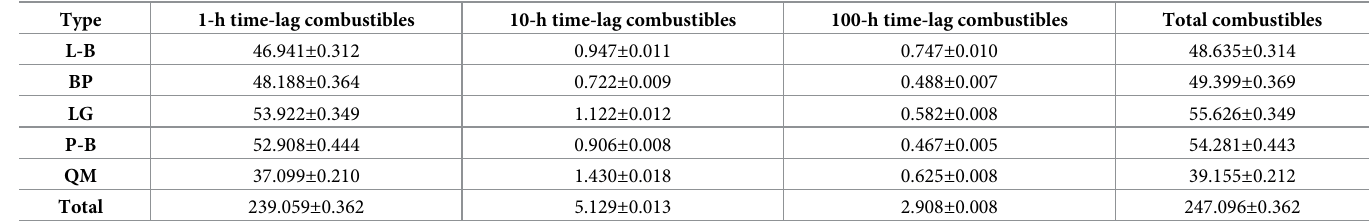
Table 4. Dead fuel load on the forest surface (kg � m − 2